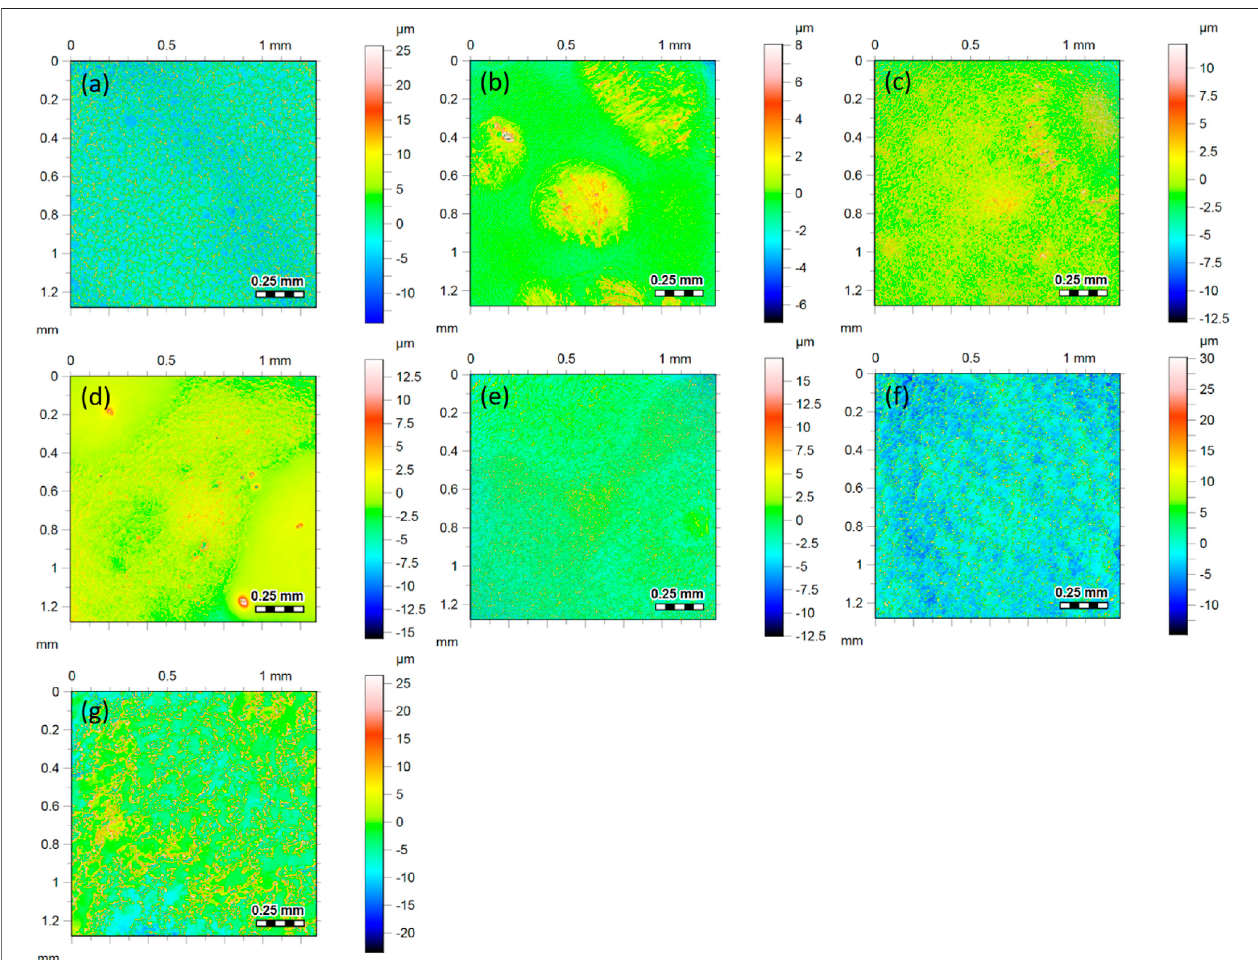
FIGURE 7 | Topographic surface images (and corresponding roughness values) obtained using CLSM surface from each of the coatings: (A) Latex ( R a (cid:1) 4.4 μ m), (B) L(Wax)( R a (cid:1) 0.5 μ m), (C) L(XG-Wax)( R a (cid:1) 1.2 μ m), (D) L(XG-Wax-0.7 μ m)( R a (cid:1) 0.7 μ m), (E) L(XG)( R a (cid:1) 2.0 μ m), (F) L(XG-0.7 μ m)( R a (cid:1) 3.3 μ m), (G) L(XG-12 μ m) ( R a (cid:1) 3.8 μ m). The images show the same area (1.2 mm by 1.2 mm), but the scale bars for the z -direction are different for each image. The areas analysed here are not the same regions studied by the friction